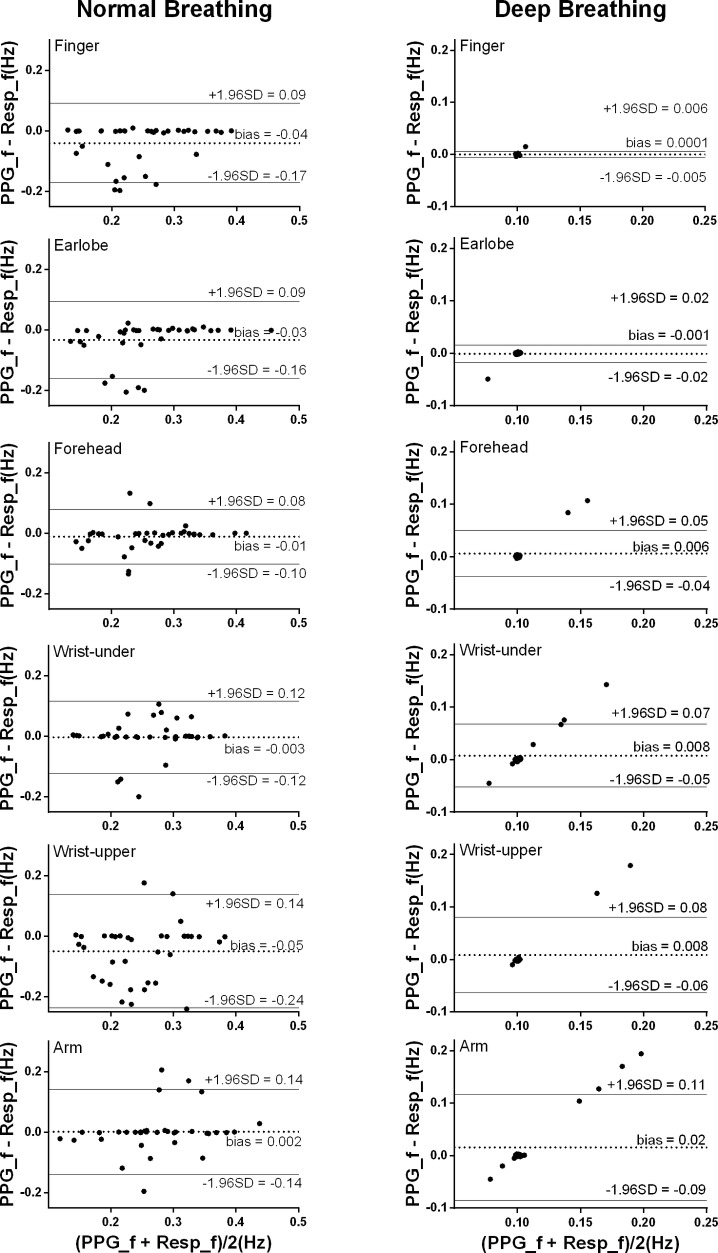
Bland-Altman results of the PPG-derived and reference RFs. The x and y axes indicate the mean and difference of the PPG-derived and the corresponding reference respiratory frequencies, respectively. The dotted lines show the mean bias. The limits of agreement (LoA) mean ± 1.96 SD interval of difference are given with the solid lines.